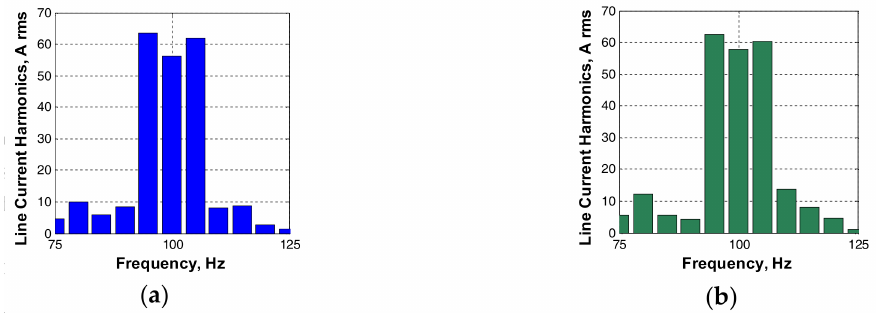
Figure 13. Ten-cycle DFT expansion of ( a ) EAF current (deduced from field data) and ( b ) APF current (deduced from simulation results) on the MV